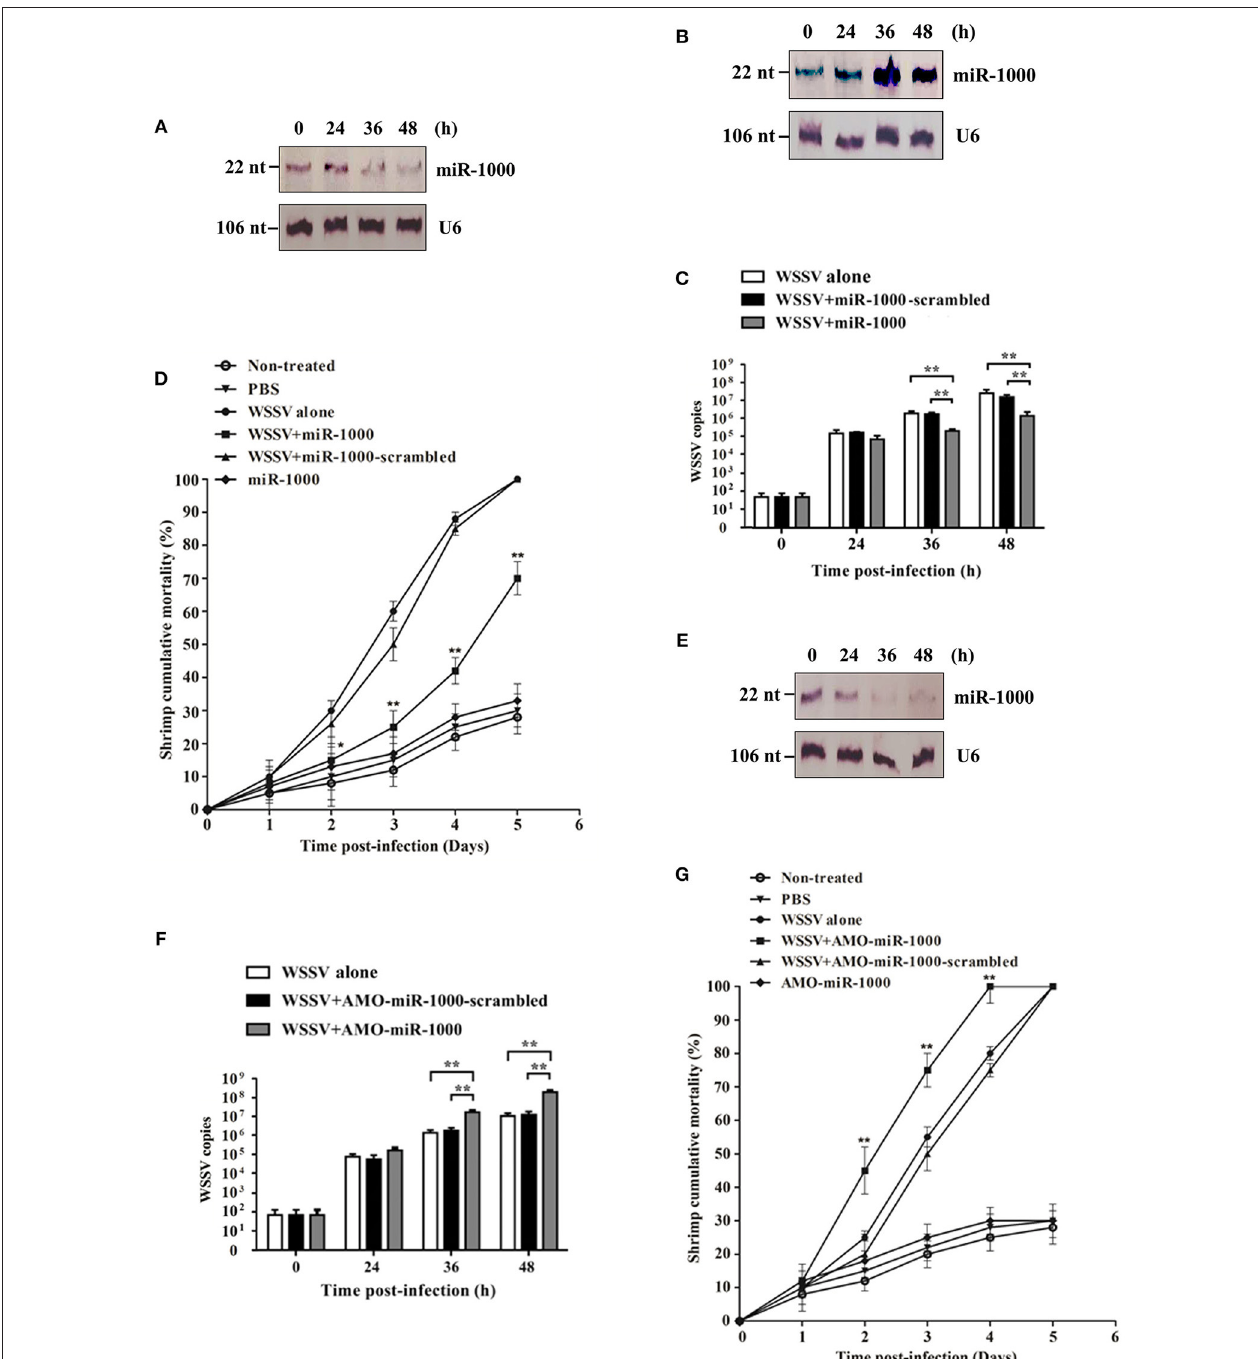
FIGURE 1 | Involvement of host miR-1000 in virus infection. (A) Downregulation of miR-1000 in shrimp in response to virus infection. Shrimp were challenged with WSSV and then subjected to Northern blot analysis to detect miR-1000 expression level. U6 was used as a control. Numbers indicated the time points post-infection. (B) Overexpression of miR-1000 in shrimp. Shrimp were injected with miR-1000 and WSSV. At different time points post-infection, the expression level of miR-1000 was evaluated using Northern blot. (C) Effects of miR-1000 overexpression on WSSV infection. Shrimp were co-injected with miR-1000 or miR-1000-scrambled and WSSV, followed by the detection of WSSV copies. WSSV alone was used as a positive control. (D) Cumulative mortality of shrimp. PBS alone, miR-1000 alone and non-treated shrimp were used as negative controls. (E) Silencing of miR-1000 in shrimp. Shrimp were co-injected with AMO-miR-1000 and WSSV. At different time points post-infection, the expression level of miR-1000 was evaluated using Northern blot. (F) Influence of miR-1000 silencing on virus infection. (G) Cumulative mortality of shrimp. As negative controls, non-treated shrimp and shrimp injected with PBS or miR-1000 were assayed. Data presented here were the mean ± standard deviation of three independent experiments. Significant differences are indicated by asterisks (* p < 0.05; ** p < 0.01).